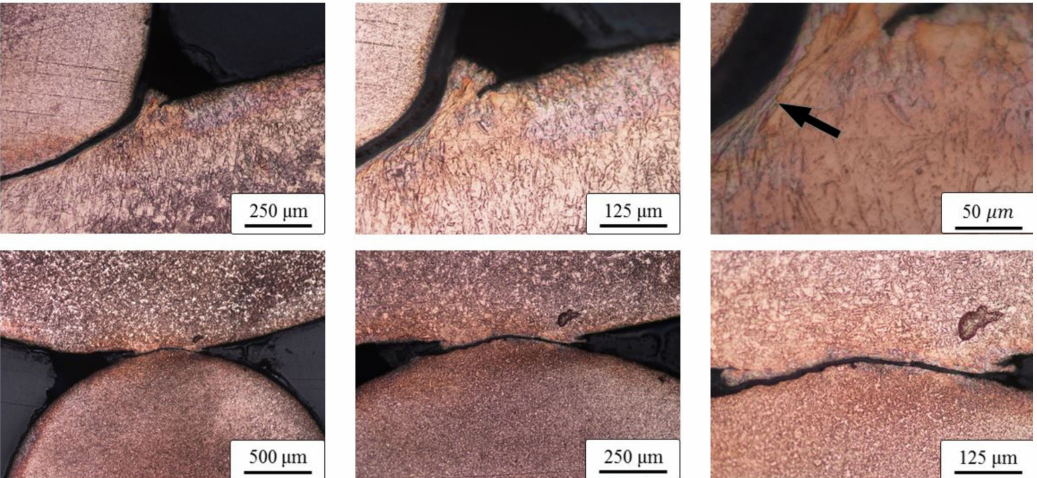
Figure 7. Metallographic images of transversal cross-sections (specimen #1.2): magnification of